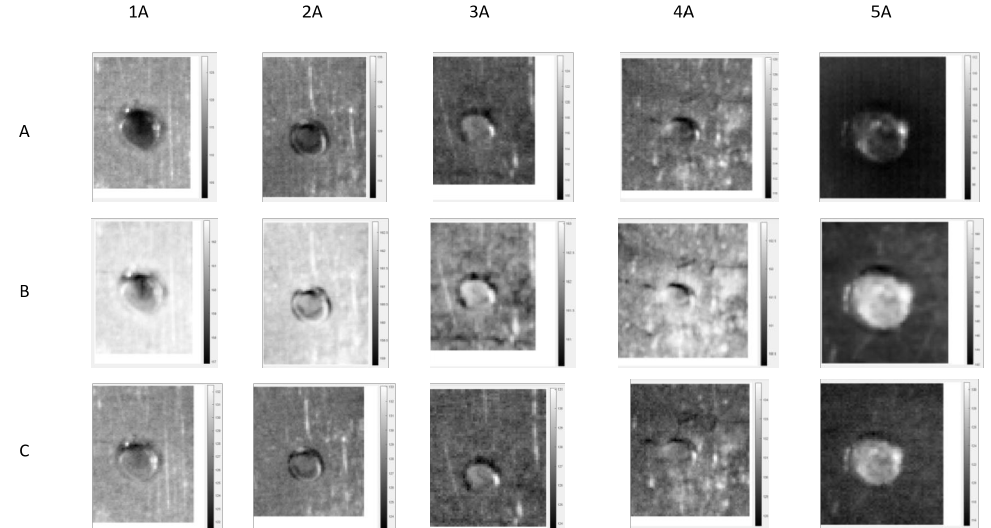
Figure 4. Snapshots taken from fast Fourier analysis for the different samples during three measure- ments. Experiment ( A ) is performed using an excitation frequency of 0.05 Hz and a Fourier frequency of 0.025 Hz, experiment ( B ) uses an excitation frequency of 0.05 Hz and a Fourier frequency of 0.05 Hz, and during experiment ( C ), the samples are excited using a frequency of 0.4 Hz and analyzed using a Fourier frequency of 0.2 Hz. Only the most interesting images are shown out of the large data sets.